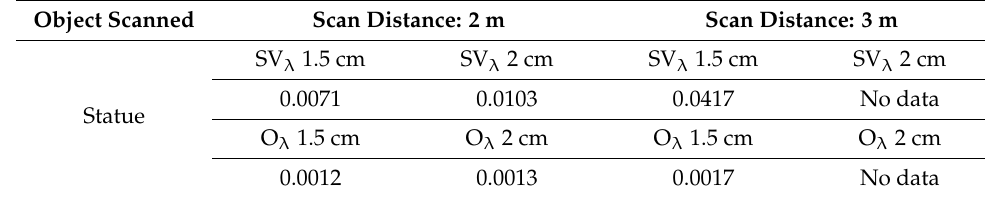
Table 5. Surface variation and planarity values of the point cloud of the lab. room, third case study.